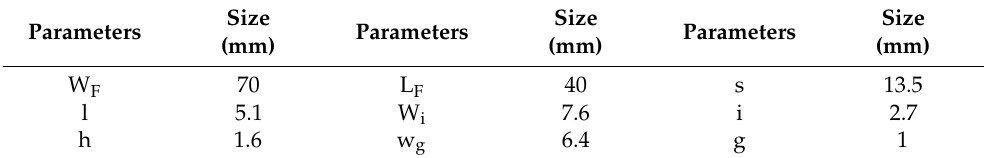
Table 1. Dimensions of the suggested antenna.